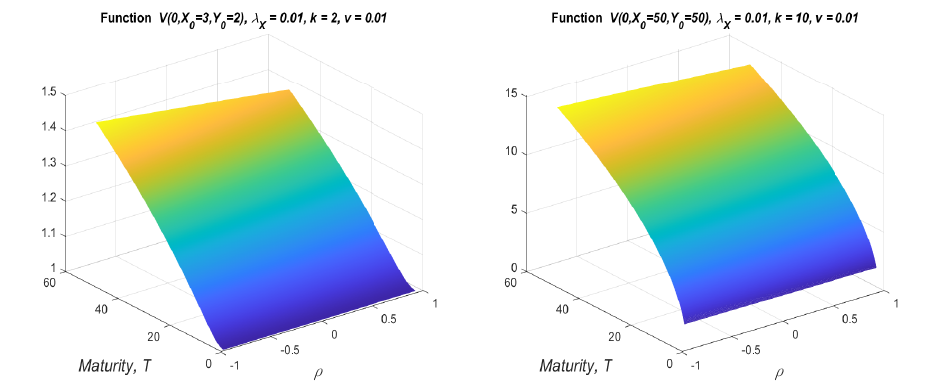
Figure 7. Dependence of value of the option V ( 0, X 0 , Y 0 ) according to Equation (37) on maturity T and ρ for X 0 = 3, Y 0 = 2 and k = 2 ( left ) and X 0 = 50, Y 0 = 50 and k = 10 ( right ).